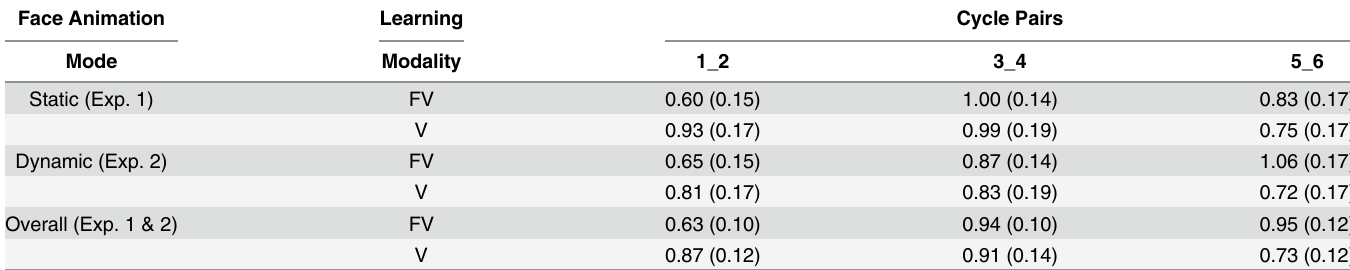
Table 1. Mean d ’ ( ± SEM) for the factors face animation mode (static vs. dynamic), learning modality (face-voice [FV] vs. voice [V]), and cycle pairs (1_2; 3_4;